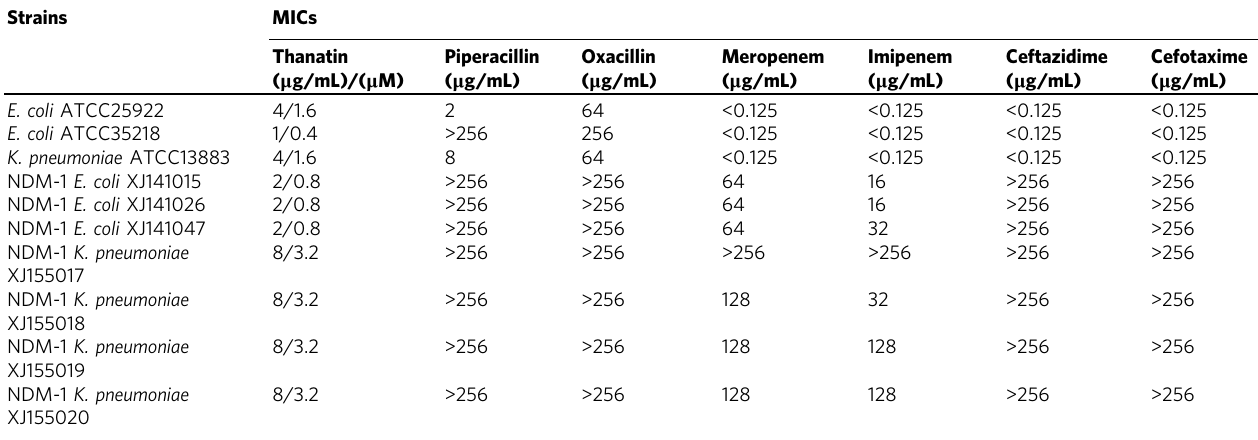
Table 1 MICs of thanatin and antibiotics in seven NDM-1-producing strains